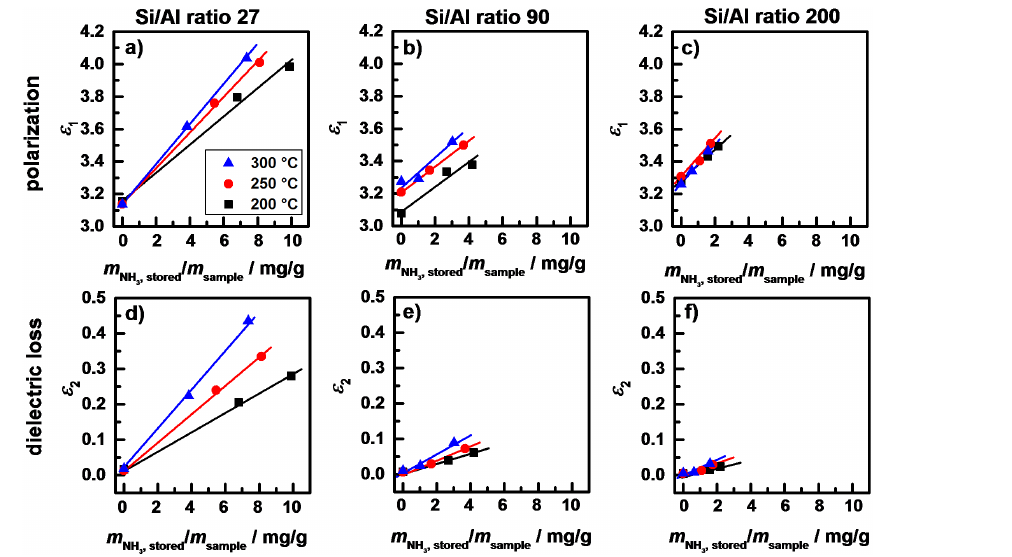
Figure 5. Dielectric permittivity of H-ZSM-5 zeolites as a function of the stored amount of ammonia normalized to the sample mass for different temperatures and Si / Al ratios (27, 90 and 200): (a) to (c) ε 1 , and (d) to (f) ε 2 .